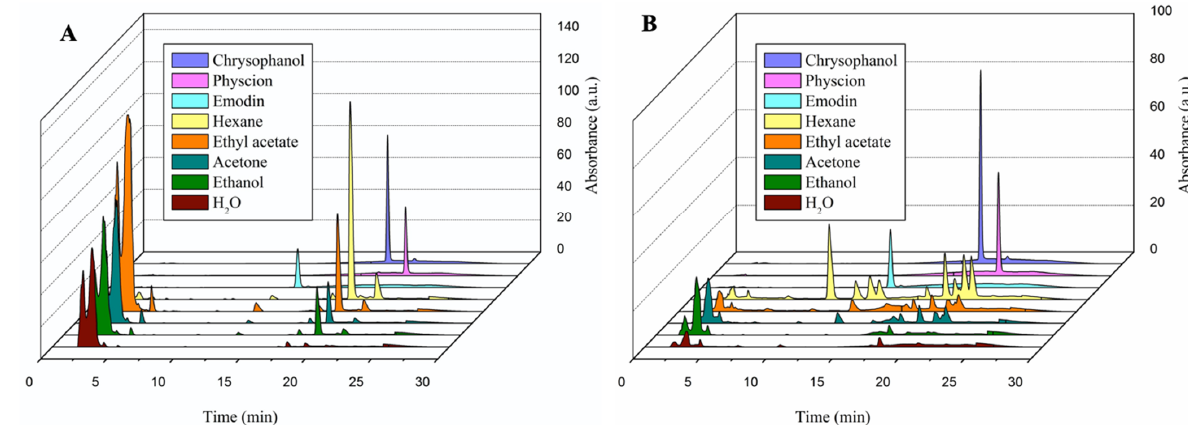
Figure 1. Identification and quantification of the bioactive constituents of Rheum undulatum L. and Rumex crispus L. through high-performance liquid chromatography. The HPLC spectrum of the bioactive constituents of Rheum undulatum L. ( RU ) ( A ) and Rumex crispus L. ( RC ) ( B ) extracts in different solvents. Chrysophanol (purple), physcion (pink), and emodin (light blue) were reference compounds. Each color represents different extract of RU and RC .